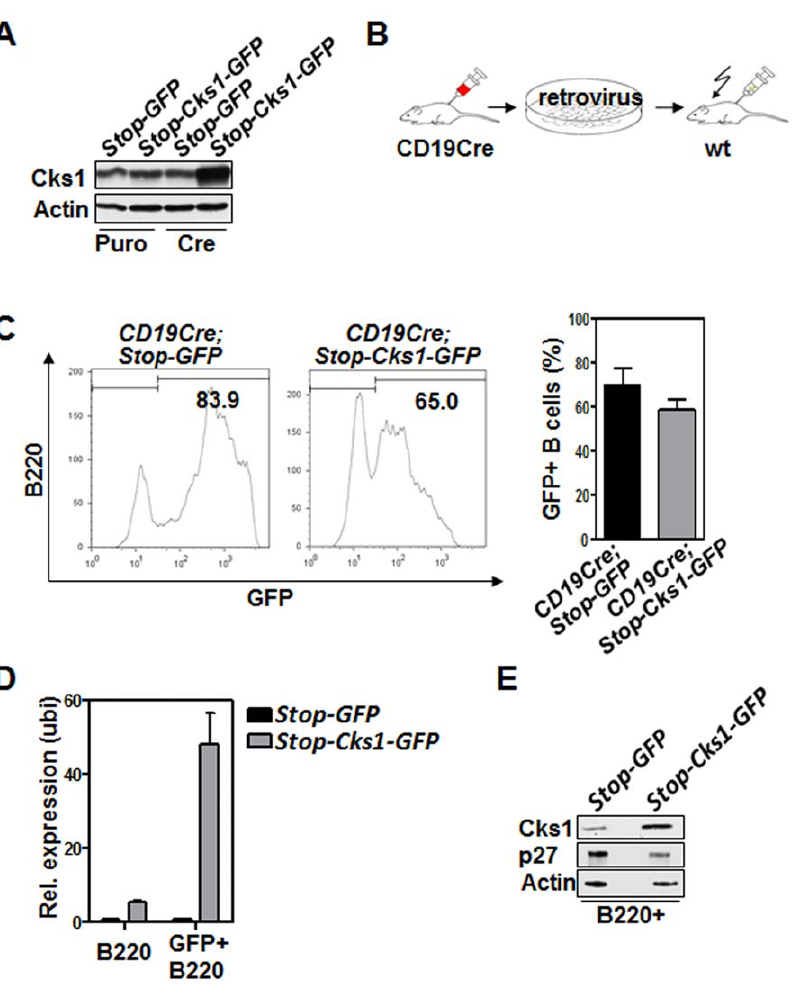
Figure 2. B cell-specific Cks1 overexpression results in elevated Cks1 protein levels. A , Immunoblot analysis of Cre-mediated conditional expression of Cks1 in retrovirally infected NIH-3T3 shows the tightness of the translational stop-cassette. Retroviral infection was performed 3 times